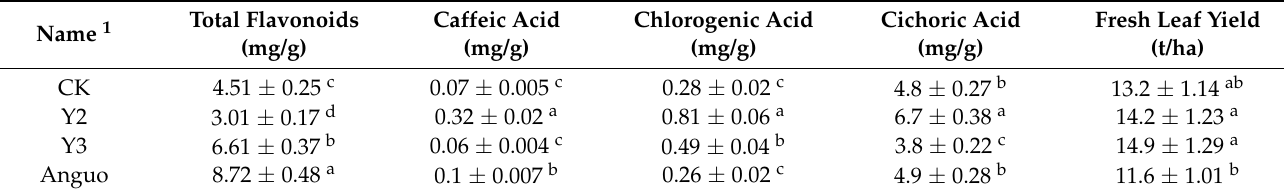
Table 2. Yield and bioactive compounds